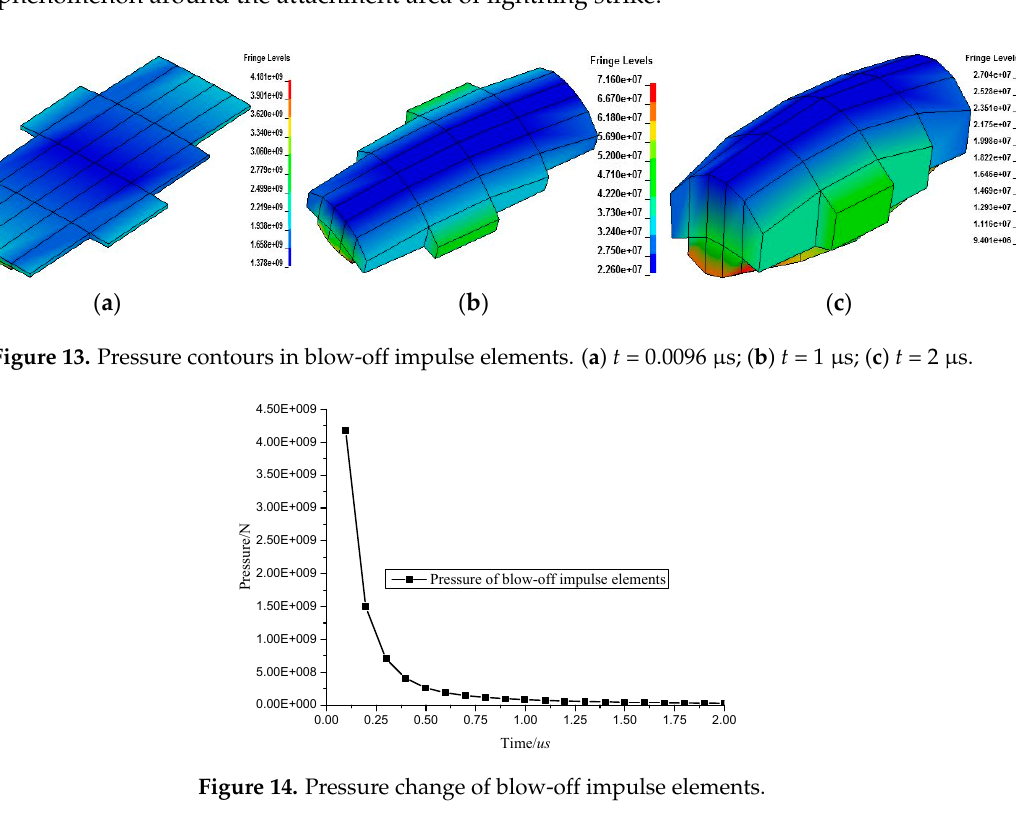
Figure 12. Damage forms in the cross-section of the composite reinforced panel.